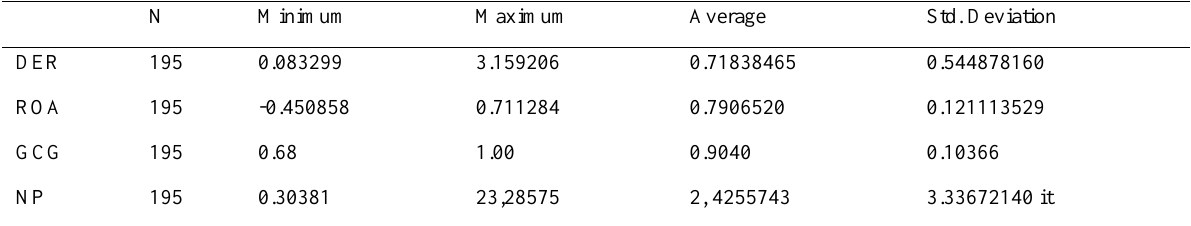
Table 1 : Descriptive Statistics Test